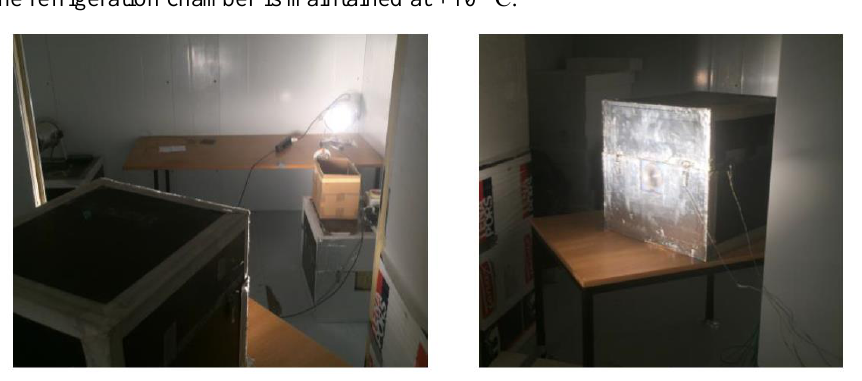
Fig. 4. Experimental setup.